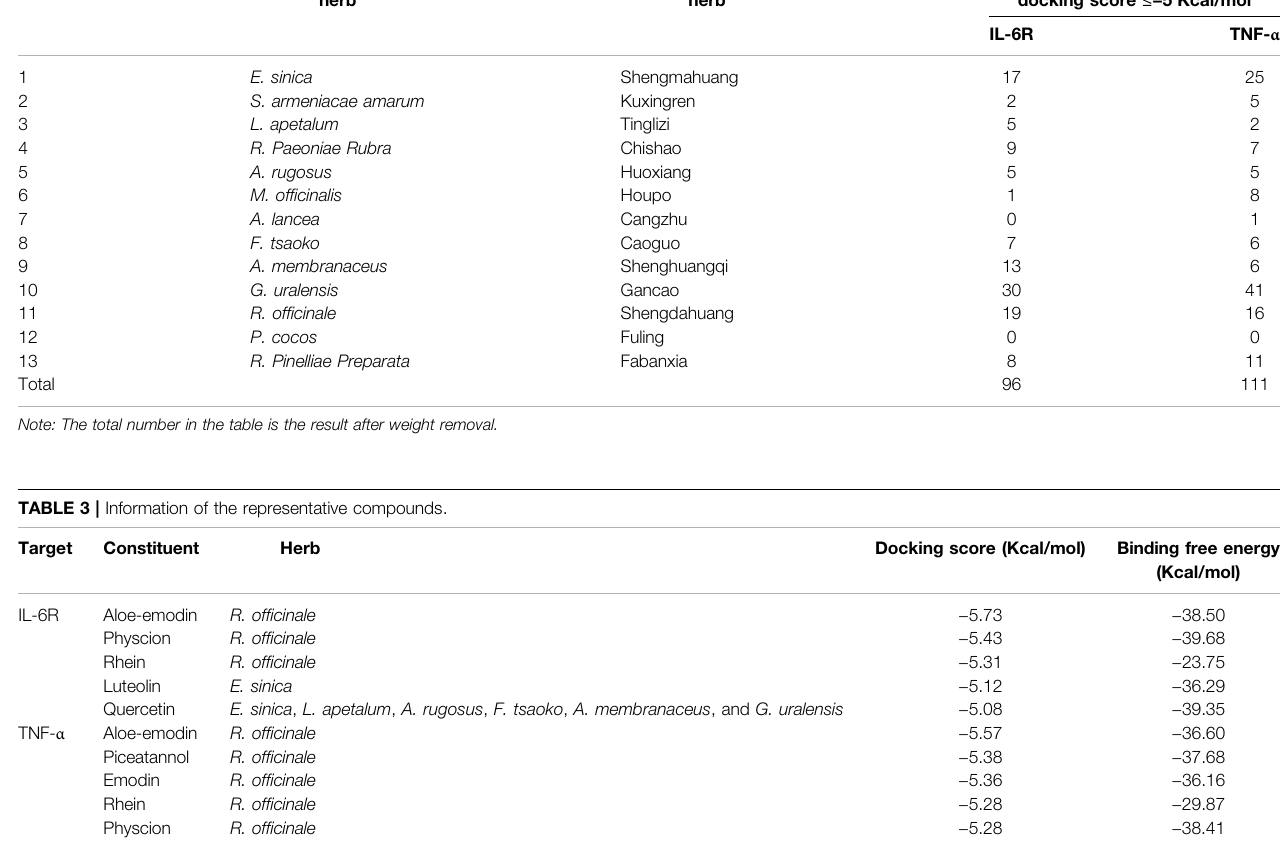
total proportion of TP53 (5/5), SRC (5/5), PIK3R1 (5/5), PIK3CA (5/5), and AKT1 (4/5) was 96%, and the results are shown in Figure 2B . The results of molecular docking showed that the prediction accuracy was high, which veri fi ed the result of PPI.